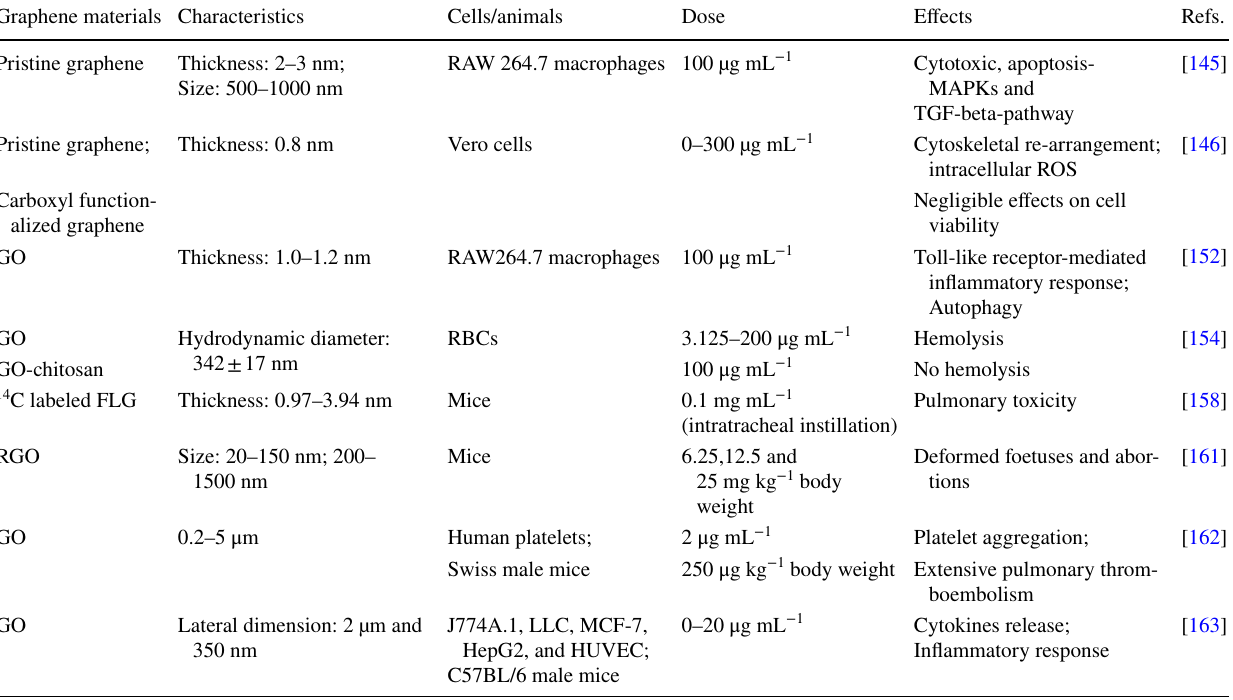
FLG Few-layered